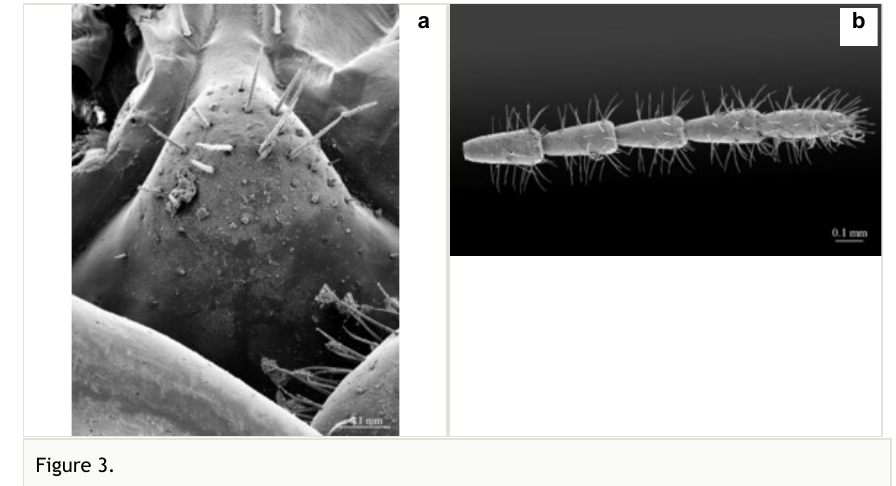
Figure 3. Eupolybothrus cavernicolus Komerički & Stoev sp. n., male paratype.